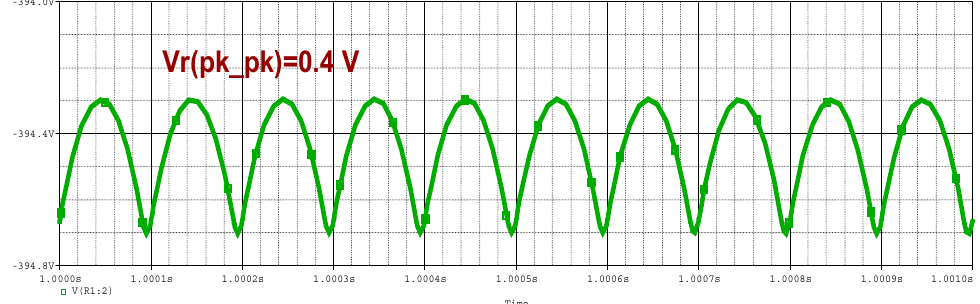
Figure 31. Output voltage ripples of the bidirectional C û k converter [33].